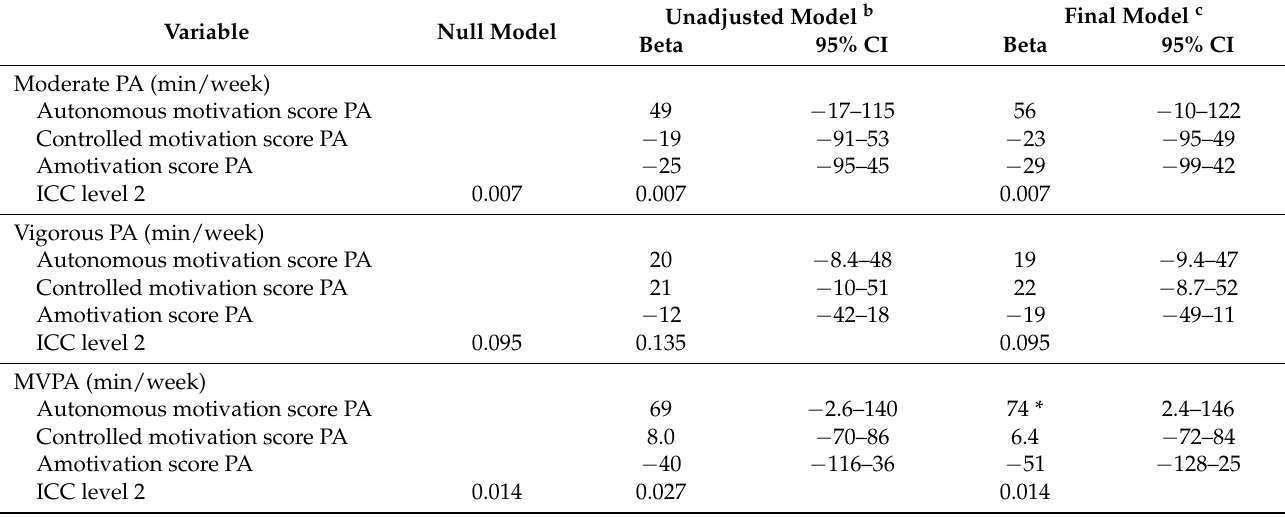
Table 5. Multilevel linear regression analysis of the associations between type of motivation and physical activity (N = 807 a